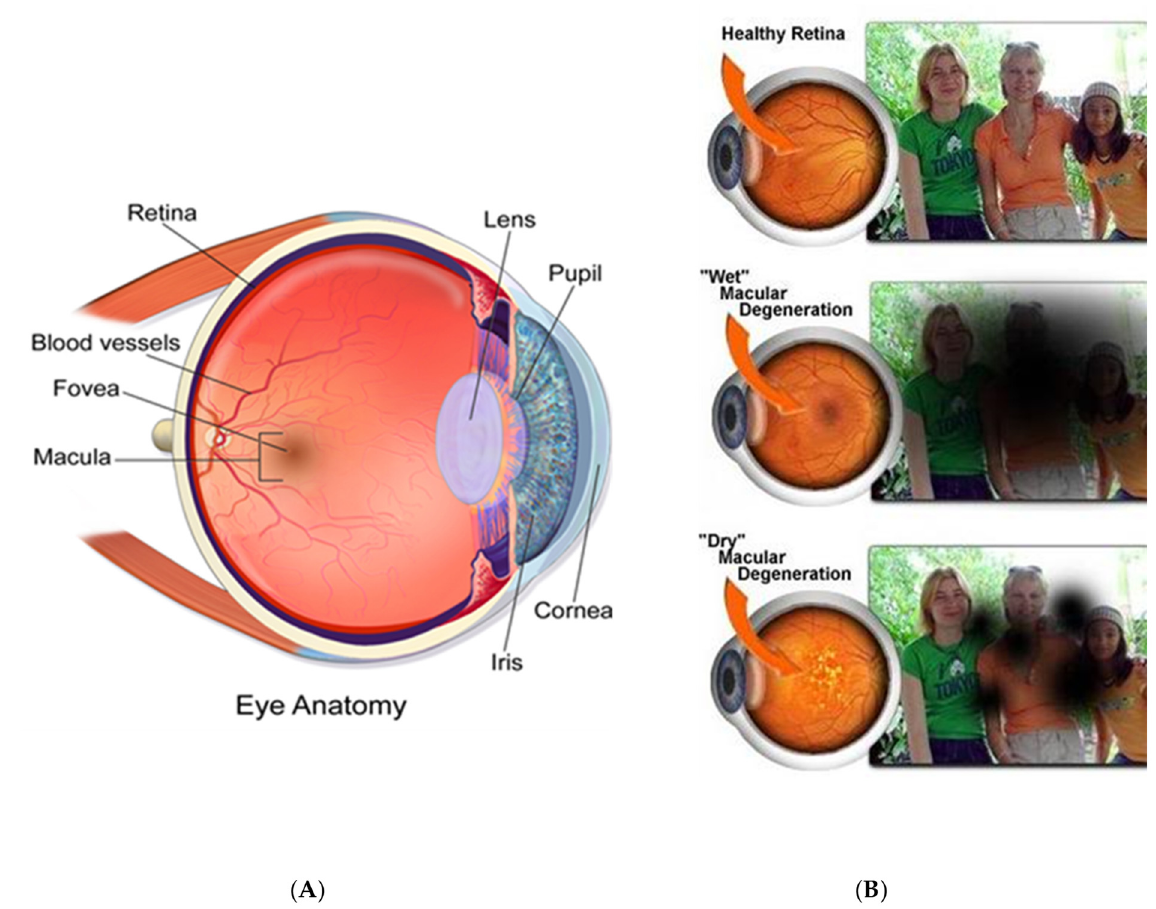
Figure 1. ( A ) Cross-section of eye; ( B ) vision after macular degeneration.